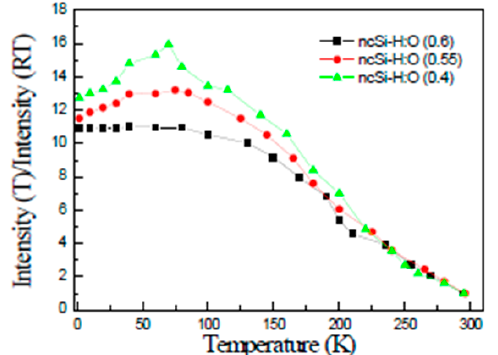
Figure 3. Integrated photoluminescence (PL) intensity of ncSi-H:O (0.6), ncSi-H:O (0.55), and ncSi-H:O (0.4), as a function of temperature. All the values of PL intensity were normalized to the values recorded at room temperature.